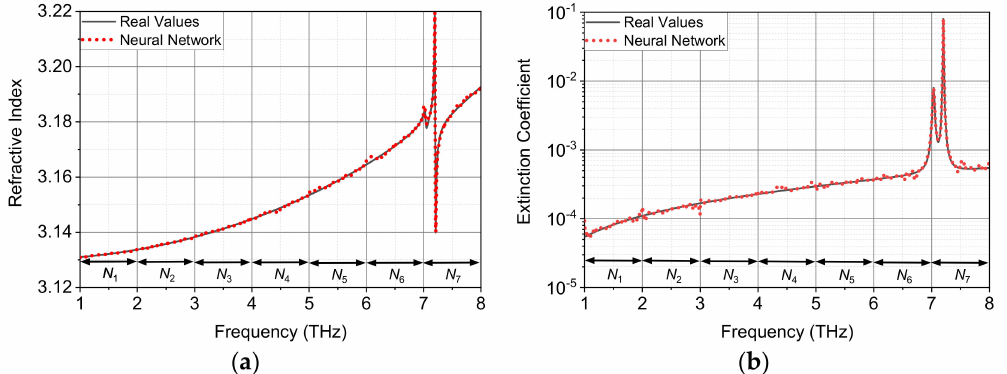
Figure 8. Comparison of extracted optical constants between the real values and neural network method for optically thin 6H SiC with a thickness of 0.05 mm: ( a ) refractive index and ( b ) extinc- tion